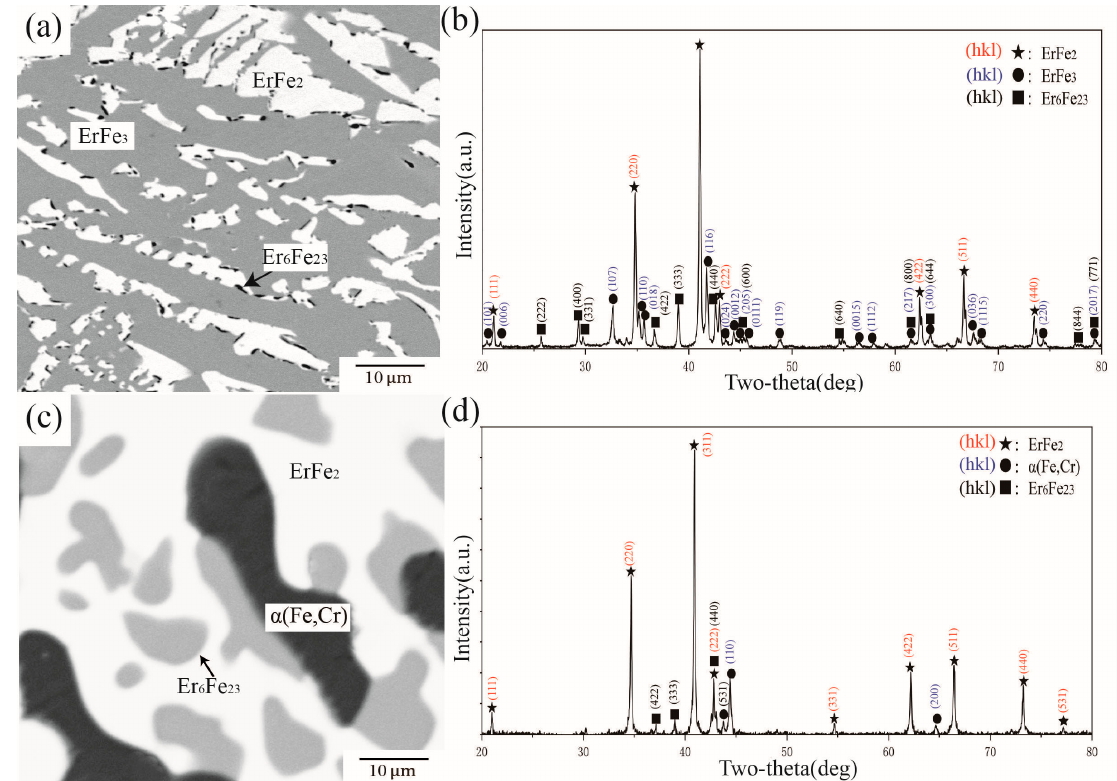
Figure 8. ( a ) BSE image of alloy A2, ( b ) XRD result of alloy A2, ( c ) BSE image of alloy A7, ( d ) XRD result of alloy A7.